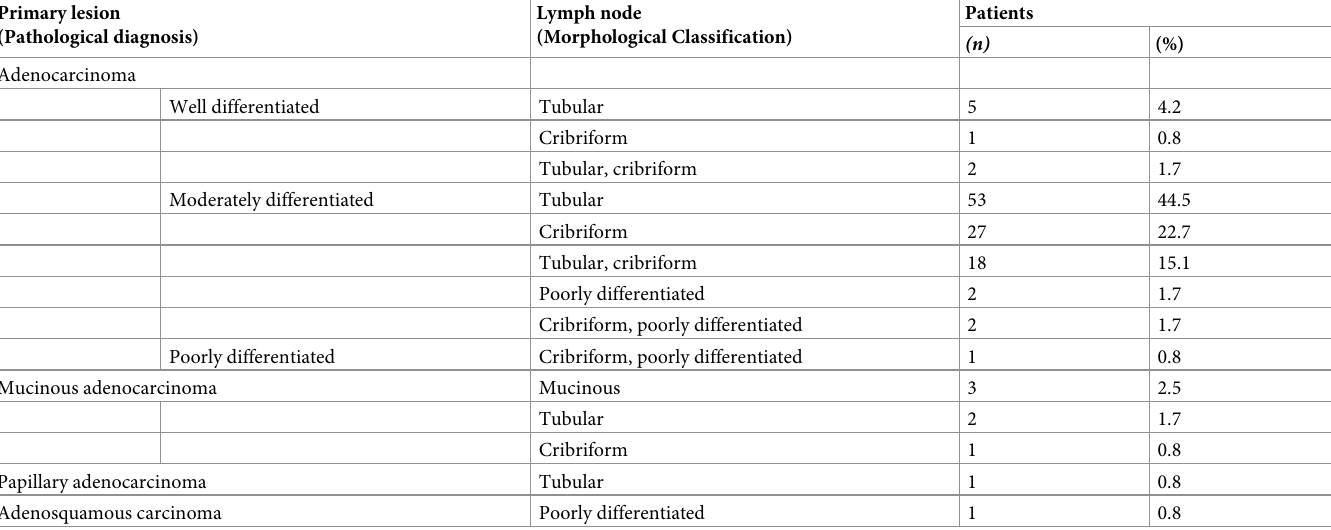
Table 1. Histologic cancer types in the lymph nodes of 119 node-positive patients with colorectal cancer. Primary lesion (Pathological diagnosis)